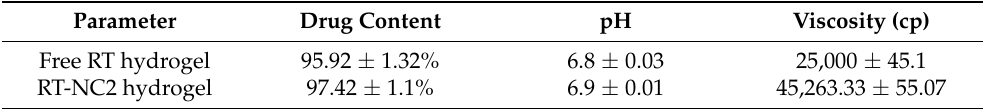
Table 5. Properties of free RT and RT-NC2 hydrogels.